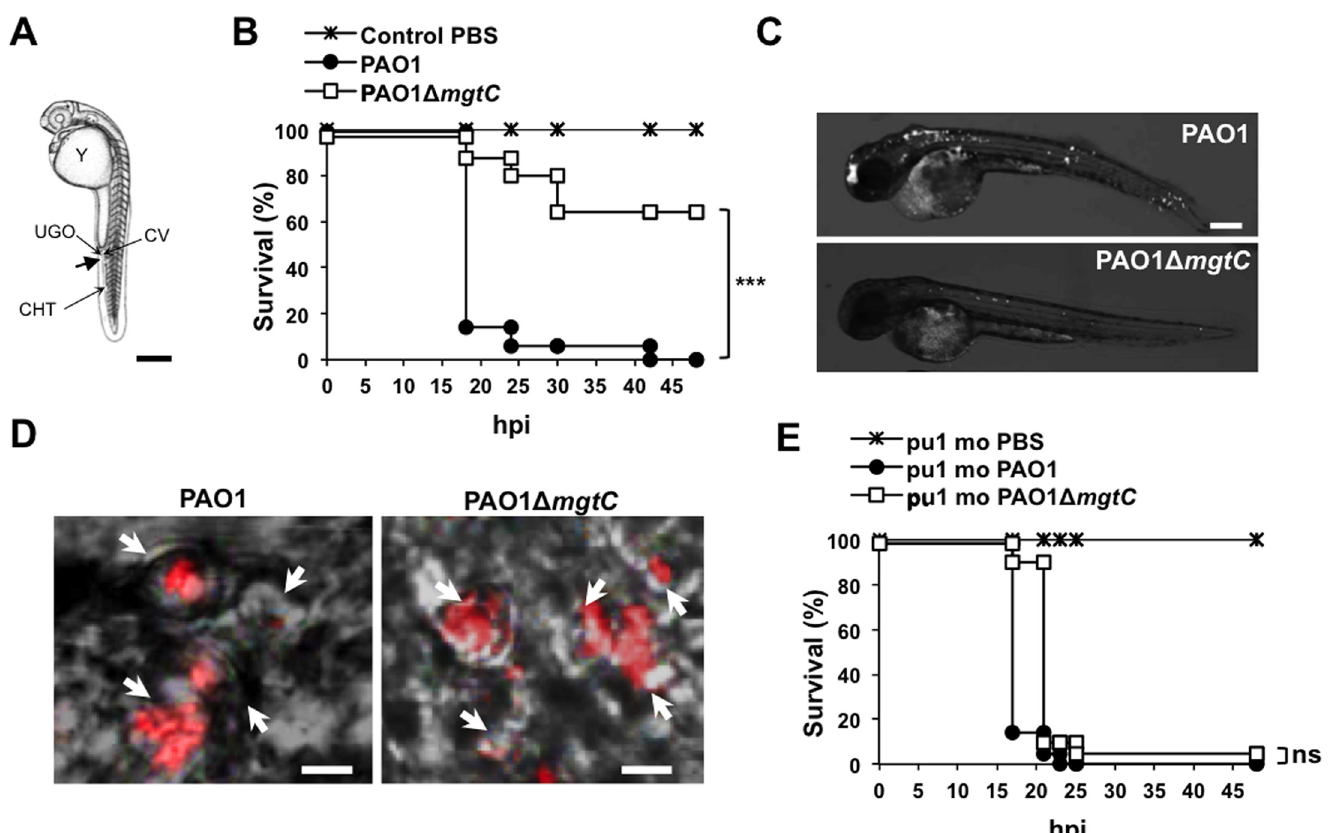
Fig 2. Infection of zebrafish embryos with the P . aeruginosa mgtC mutant. (A) Diagram of 30 hours post-fertilization (hpf) zebrafish embryo showing the injection site used in this study (arrow). All injections were done in the caudal vein (CV) just behind to the urogenital opening (UGO). Y: Yolk, CHT: Caudal Hematopoietic Tissue. Scale bar, 100 μ m. (B) Survival curves of embryos infected with PAO1 wild-type stain or PAO1 Δ mgtC mutant and PBS-injected (control). Approximately 1200 – 1400 CFU P . aeruginosa were microinjected into the caudal vein (n = 20 per group). Results are expressed as the percentage of surviving on each hour post-infection. Representative results of three biologically independent replicates are shown. Embryos are significantly more susceptible to infection with PAO1 wild-type than Δ mgtC mutant ( P < 0.001). (C) 30 hpf embryons are intravenously infected with PAO1 or Δ mgtC mutant expressing mCherry. Representative fluorescence microscopy images of 18 hpi embryos infected with PAO1 (top panel) or PAO1 Δ mgtC mutant (bottow panel) are shown (1200 – 1400 CFU). Scale bar, 200 μ m. (D) 30 hpf zebrafish embryos are intravenously infected with mCherry-expressing PAO1 (left panel) or PAO1 Δ mgtC mutant (right panel) and imaged by confocal microscopy. Arrows indicate maximum intensity projection of macrophages that phagocytose bacteria close to the site of injection at 1 hpi. Scale bar, 10 μ m. (E) Survival curves of pu . 1 morphant ( pu . 1 mo) embryos (n = 20 each) infected with 900 CFU of PAO1 wild type stain or PAO1 Δ mgtC mutant compared to the PBS- injected control. Representative results of three biologically independent replicates are shown. No statistically significant difference is obtained between wild type-infected embryos and Δ mgtC mutant-infected embryos (ns: non